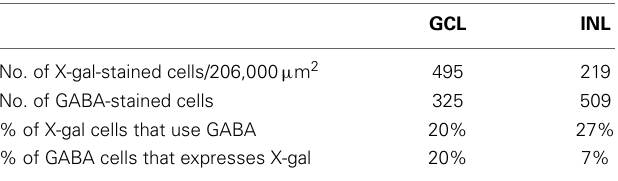
Table 1 | Percentage of PDE9A-expressing cells in retina (averages of 3